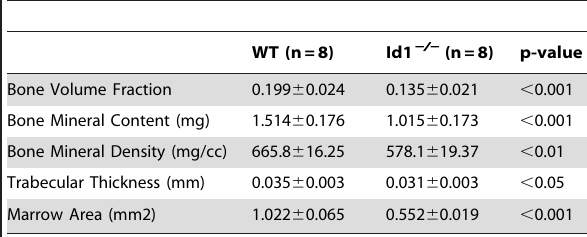
Table 1. Characteristics of femurs in 6-week old wild-type and Id1 2 / 2